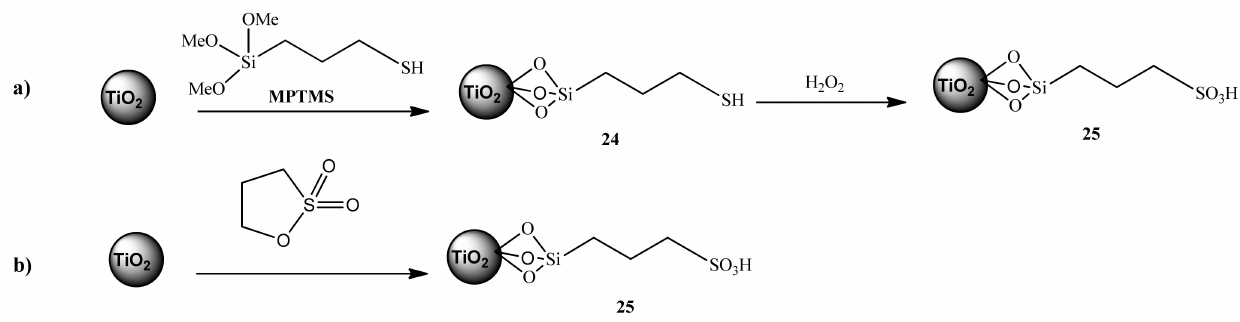
Figure 9. Grafting procedure of MPTMS ( a ) and 1,3-propanesultone ( b ) for the preparation of propyl sulfonic titania from refs [42,54]